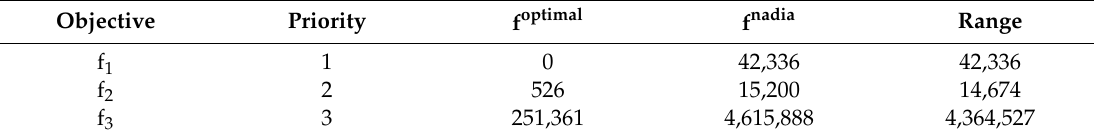
Table 4. The optimal value, the worst value and the range of the objective functions.